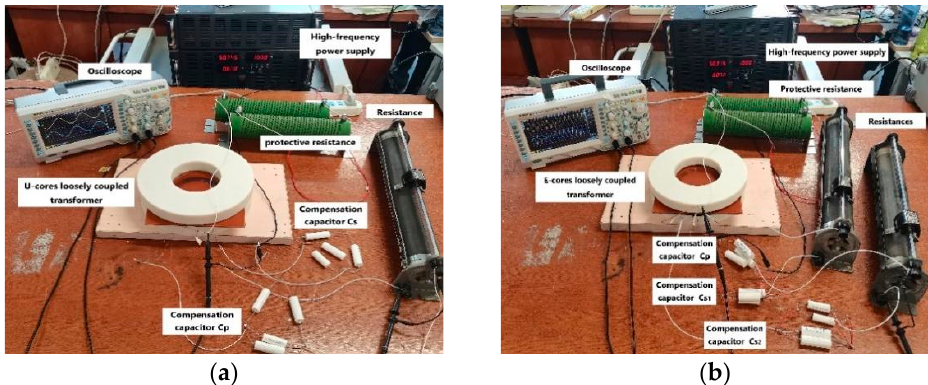
Figure 12. Magnetically coupled structure: ( a ) U-shaped; ( b ) E-shaped.